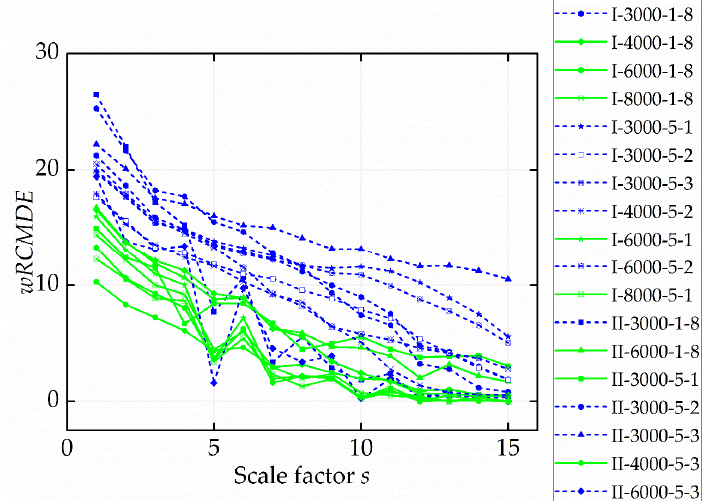
Figure 5. wRCMDE extracted from the reconstructed signals with different scale factors. Green lines indicate a chatter-free state, and blue dashed lines indicate a chatter state.